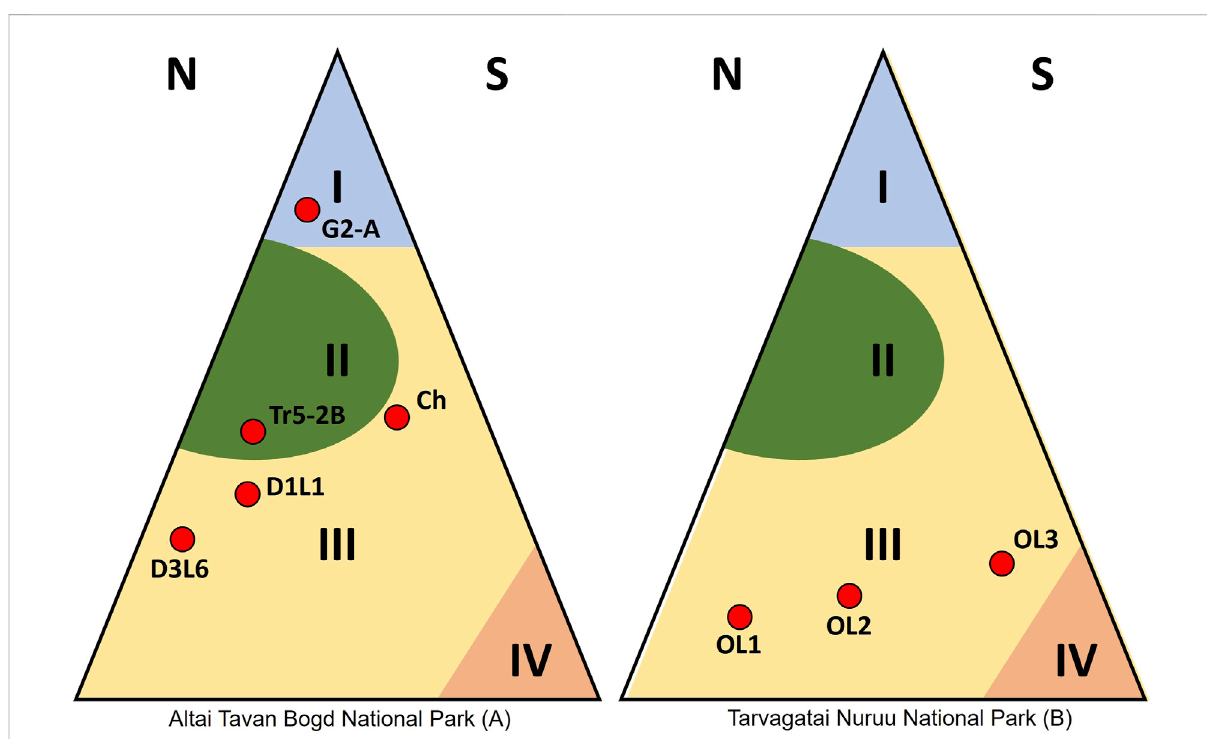
FIGURE 2 Locations of cores within vegetation zones, I: High-mountain zone ( > 2,100 m a.s.l.), II: Mountain forest zone (1,700 – 2,200 m a.s.l.), III: Mountain steppe zone (1,600 – 3,200 m a.s.l.), and IV: Desert zone (1,100 – 2,100 m a.s.l.); zonation after Beket and Knapp (2012).